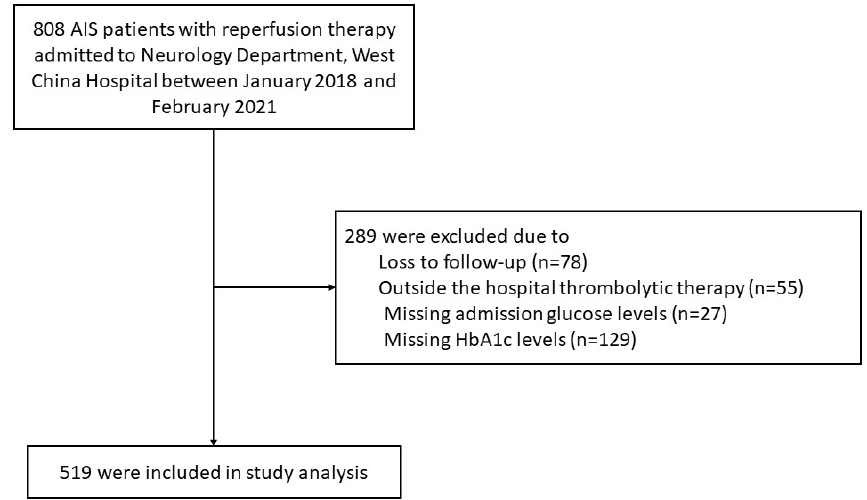
Figure 1. Patients flow chart. AIS, acute ischemic stroke; HbA1c, hemoglobin A1c. The mean age of the 519 participants was 69 years (SD: 13.4 years); 279 partici- pants (53.8%) were men. The mean level of admission glucose was 8.51 mmol/L (SD: 3.13 mmol/L). A total of 47.4% of patients had aHG. The mean level of HbA1c was 6.39% (SD: 1.35%). A total of 29.9% of patients had high HbA1c levels. Compared with